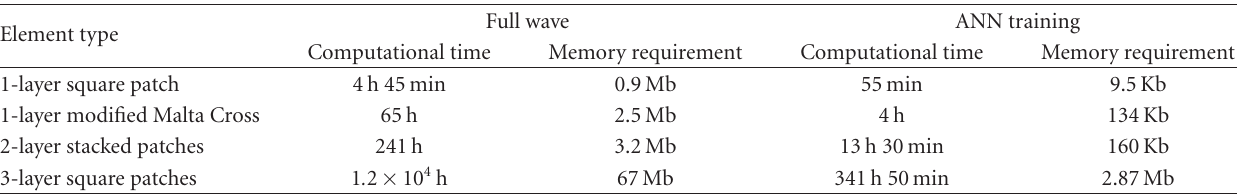
Figure 7: Reflection coe ffi cient amplitude (left) and phase (bottom) versus the two RA geometrical parameters (cid:2) and t of the modified Malta Cross, computed with direct full-wave (top) and reconstructed with the ANN (bottom). f = 11 . 7 GHz, θ inc = 0 ◦ . Table 1: Computational time and memory requirement for the evaluation and the storage of the reflection coe ffi cient maps for di ff erent types of re-radiating elements, with the periodic full-wave approach and the ANN